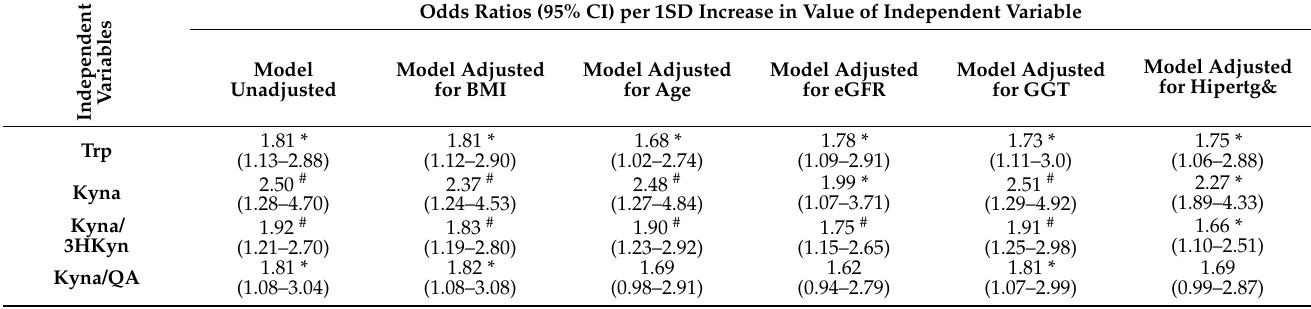
Table 4. The associations between Trp and KP metabolites with T2D in logistic regression models.